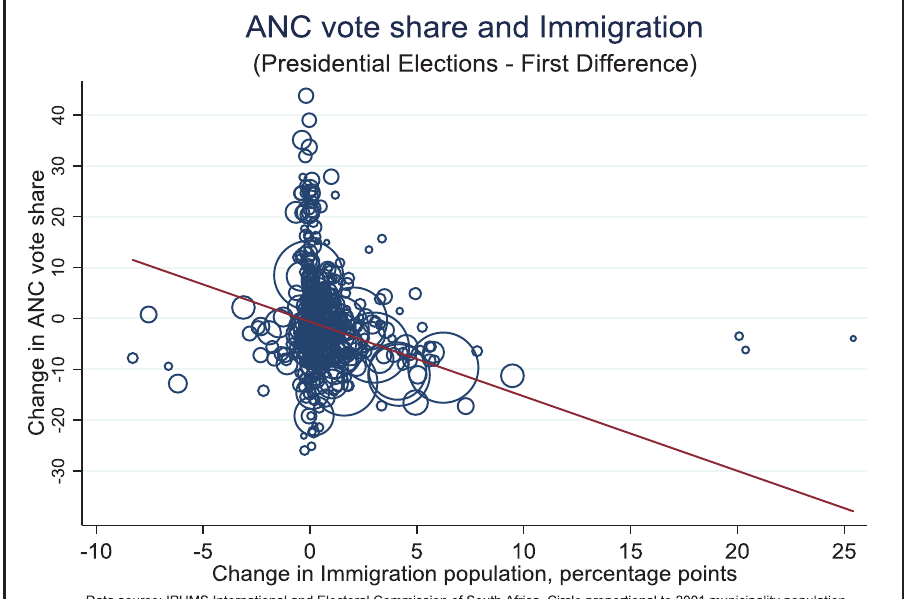
Figure 10 ANC vote and immigration.